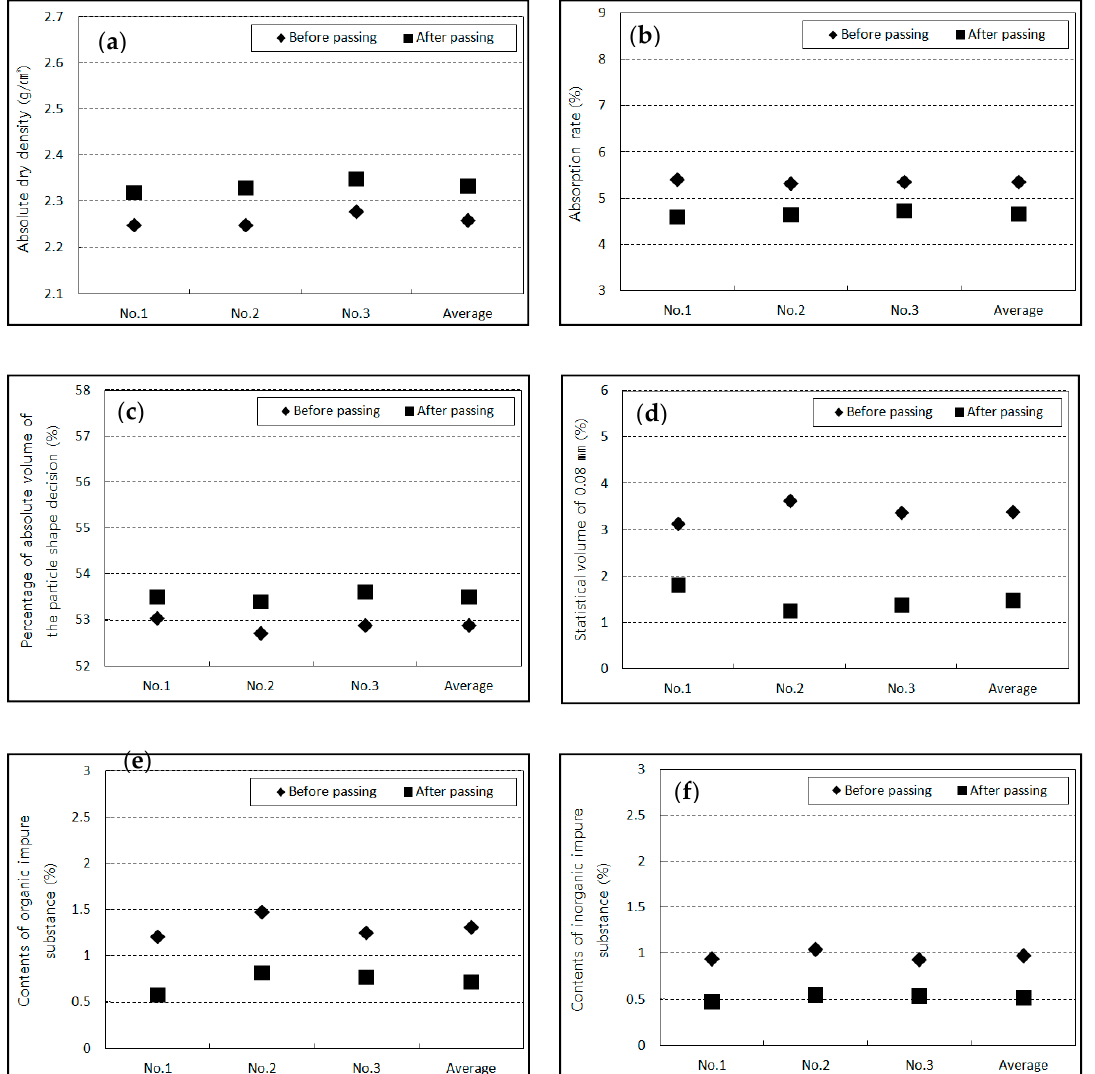
Figure 6. ( a ) Absolute dry density, ( b ) absorption rate, ( c ) percentage of absolute volume of the particle shape, ( d ) statistical volume of 0.08 mm, ( e ) contents of organic impurities, and ( f ) contents of inorganic impurities of recycled fine aggregate, before and after passing.